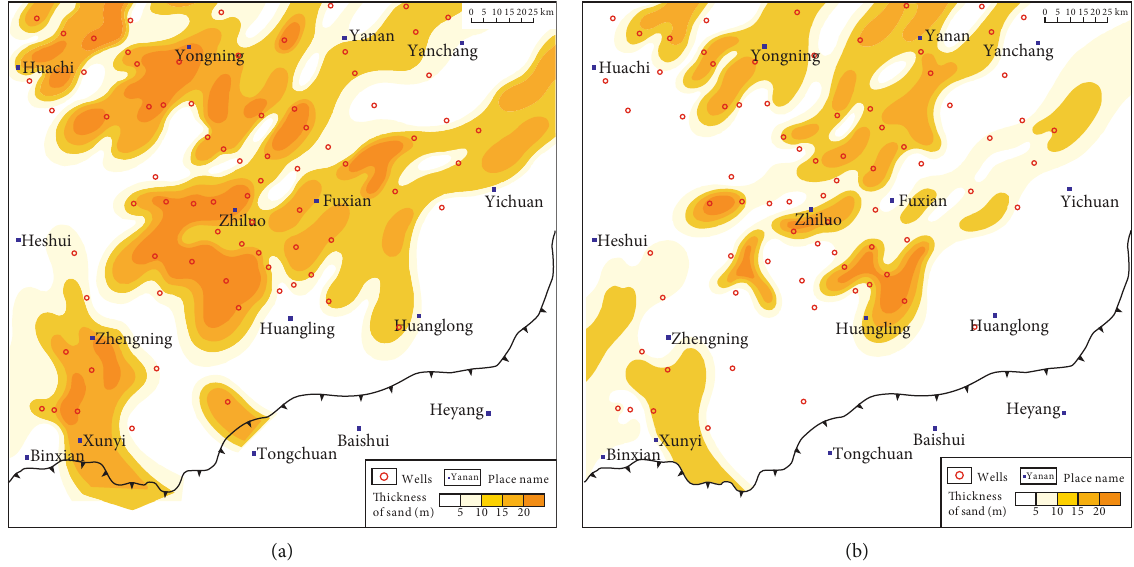
Figure 13: Thickness of sand body in the study area: (a) thickness of sand body, Chang 7